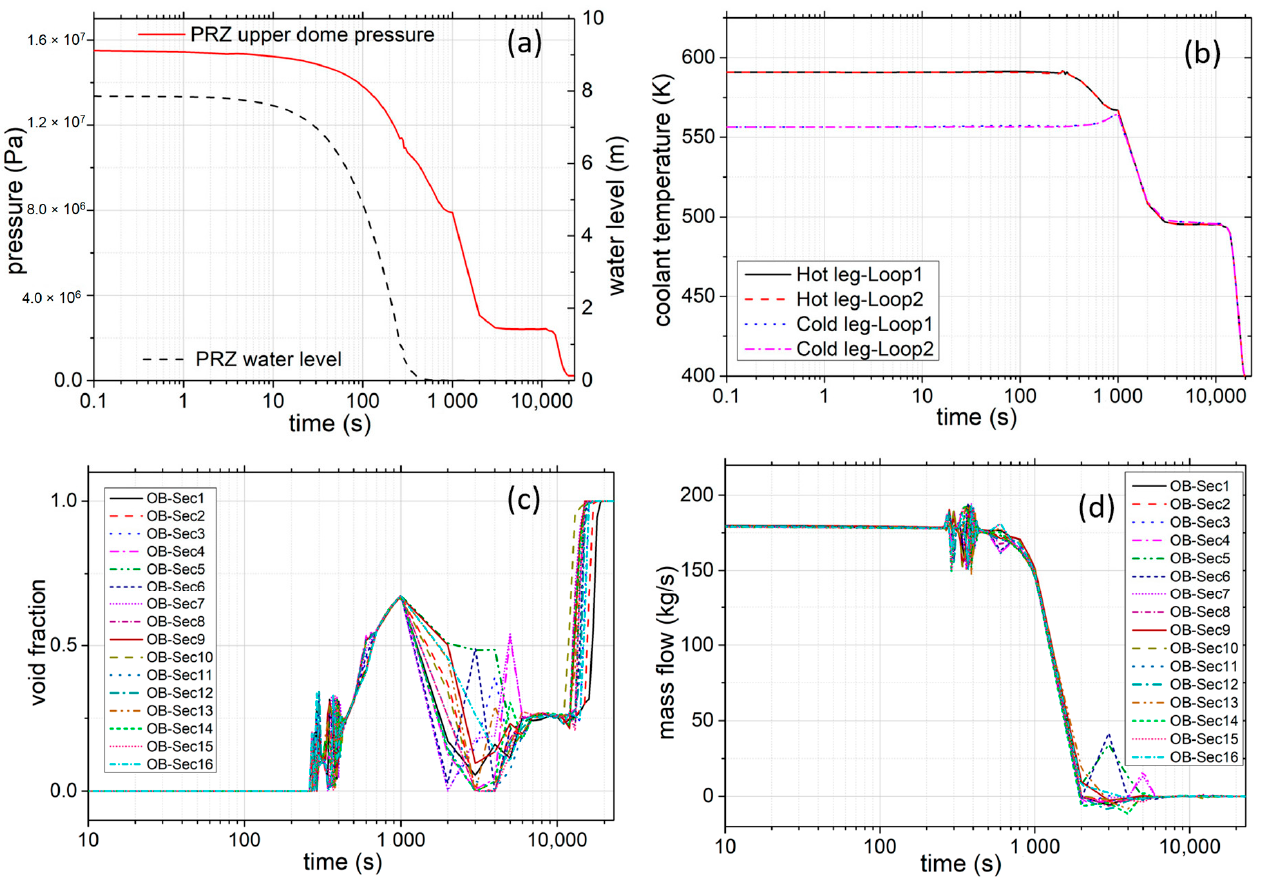
Figure 2. Ex-vessel small rupture of water-cooled blanket coolant circuit pipe: ( a ) pressurizer pressure and water level; ( b ) coolant temperature; ( c ) void fraction of coolant; ( d ) mass flow of